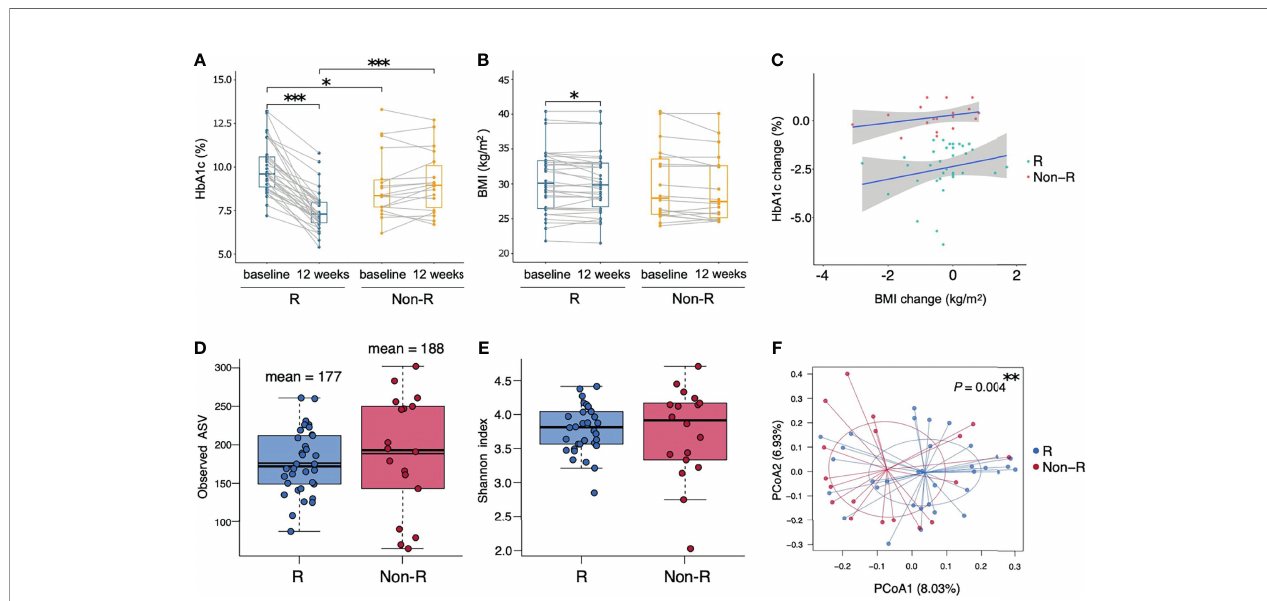
FIGURE 1 | Therapeutic outcomes and microbiota biodiversity of type 2 diabetic patients receiving GLP-1 RA treatment. (A, B) Responders had signi fi cant reductions in both HbA1c and BMI ( P < 0.001 and P = 0.041 respectively, Wilcoxon signed rank tests), whereas non-responders had insigni fi cant changes. Responders had a higher HbA1c than non-responders at baseline and a lower HbA1c at week 12 ( P = 0.012 and P < 0.001 respectively, Wilcoxon rank sum tests). (C) Correlations between the change from the baseline of HbA1c and BMI in the two groups were not signi fi cant ( P > 0.05, Pearson ’ s correlation). (D, E) Similar alpha diversity of the bacterial microbiota in the two groups, based on observed ASV numbers and Shannon index ( P = 0.376 and P = 0.832 respectively, Wilcoxon rank sum tests). The mean observed ASVs are shown as additional thin lines in boxes. (F) There was a difference in beta diversity between the two groups by PCoA ( P = 0.004, ADONIS). Each point represented each individual, colored according to treatment responses. In all panels: * P < 0.05; ** P < 0.01; *** P < 0.001. Groups are responders (R) and non- responders (Non-R). HbA1c, glycohemoglobin; BMI, body mass index; ASV, amplicon sequence variant; PCoA, principal coordinate